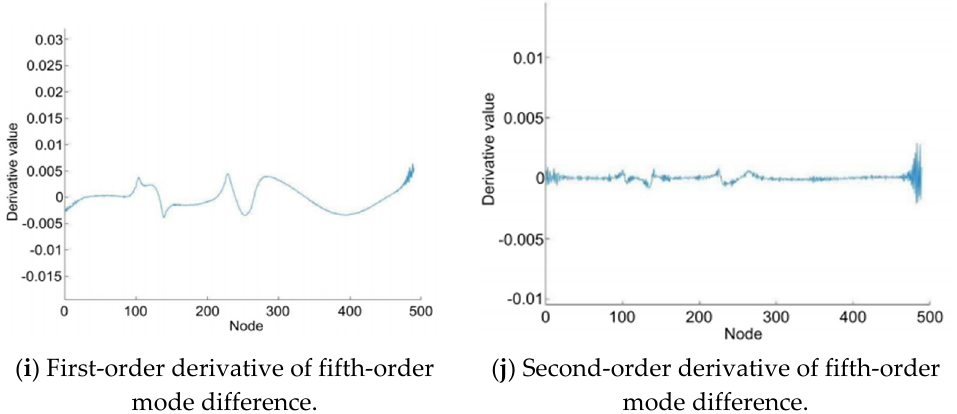
Figure 27. First-order and second-order derivatives of the differences of the first five orders of modes under Conditions 5 and 8.